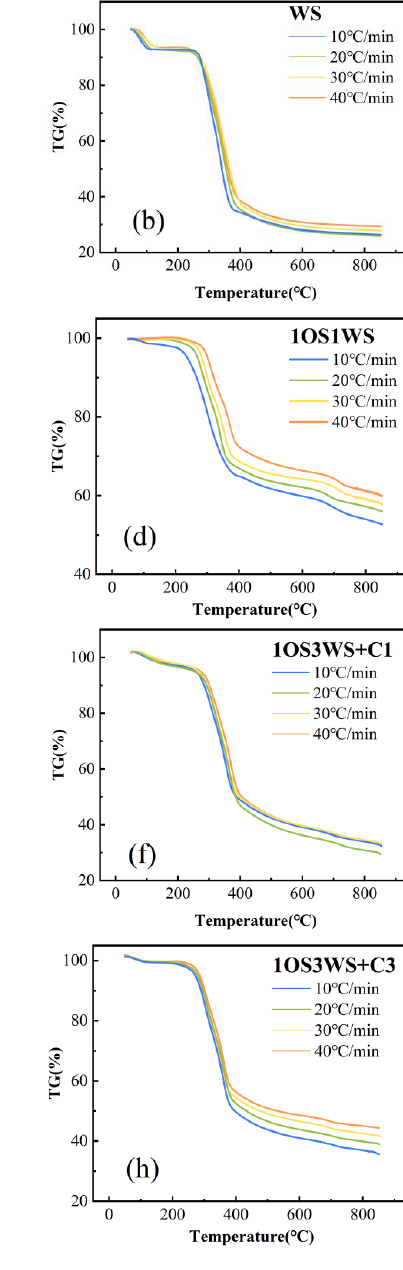
Figure 3. TG curves of ( a ) OS, ( b ) WS, ( c – e ) their mixtures, and ( f – h ) mixture with catalysts at different heating rates.